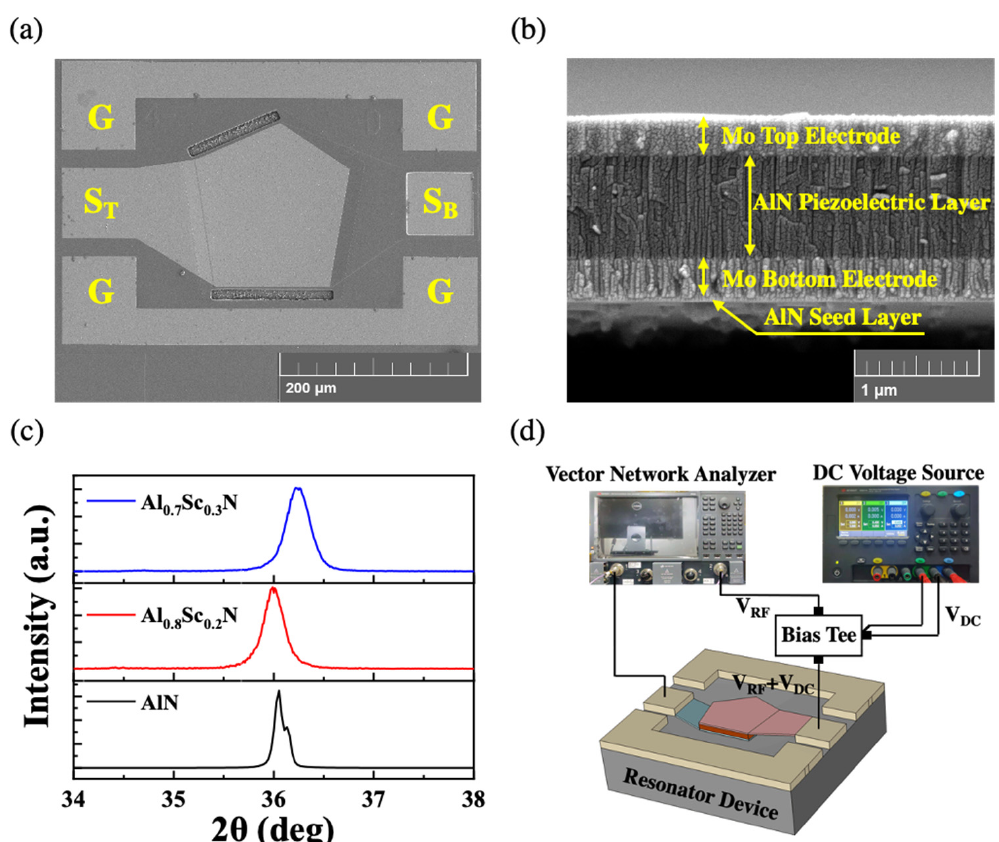
Figure 1. Characterization and experimental measurement of FBARs. ( a ) Morphology of the designed resonator; ( b ) Cross-sectional view of the AlN-based FBAR; ( c ) X-ray diffraction (XRD) results of AlN, Al 0.8 Sc 0.2 N and Al 0.7 Sc 0.3 N piezoelectric thin films; ( d ) Schematic of the measurement setup.